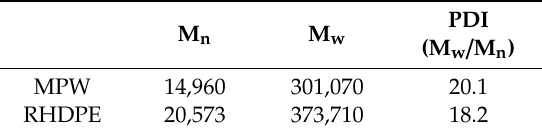
Table 6. Molecular weight of raw plastic materials obtained from gel permeation chromatography (GPC) analysis.